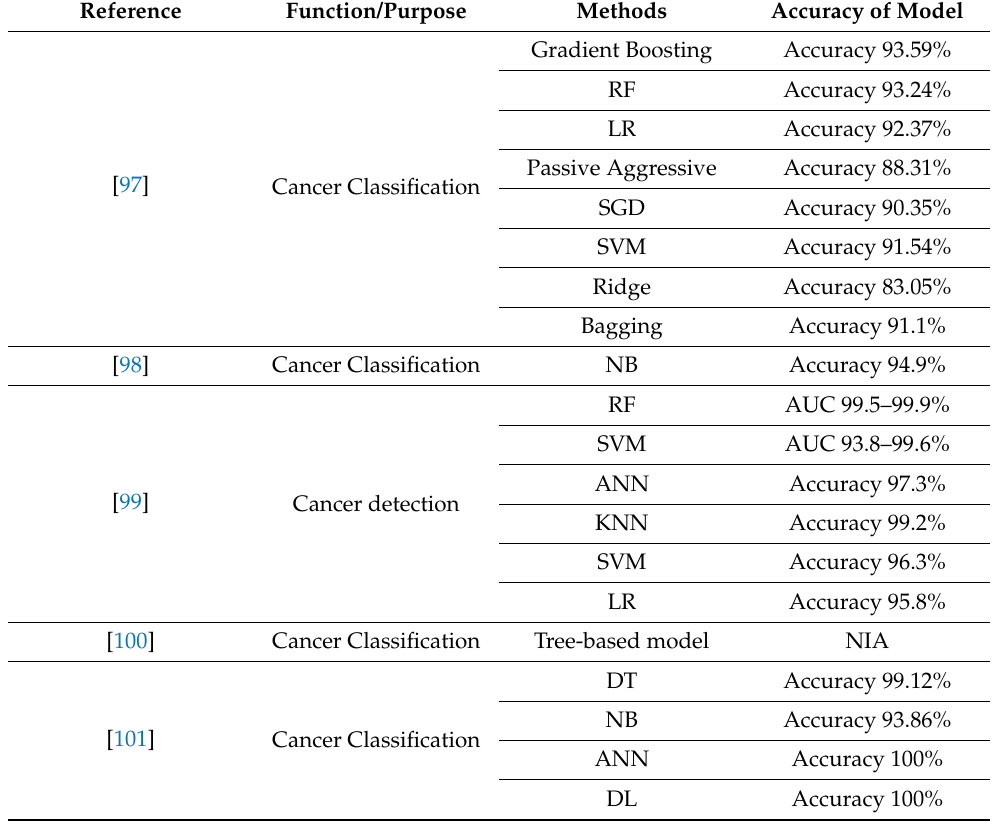
Table 5. Related work for BC studies with miRNA as